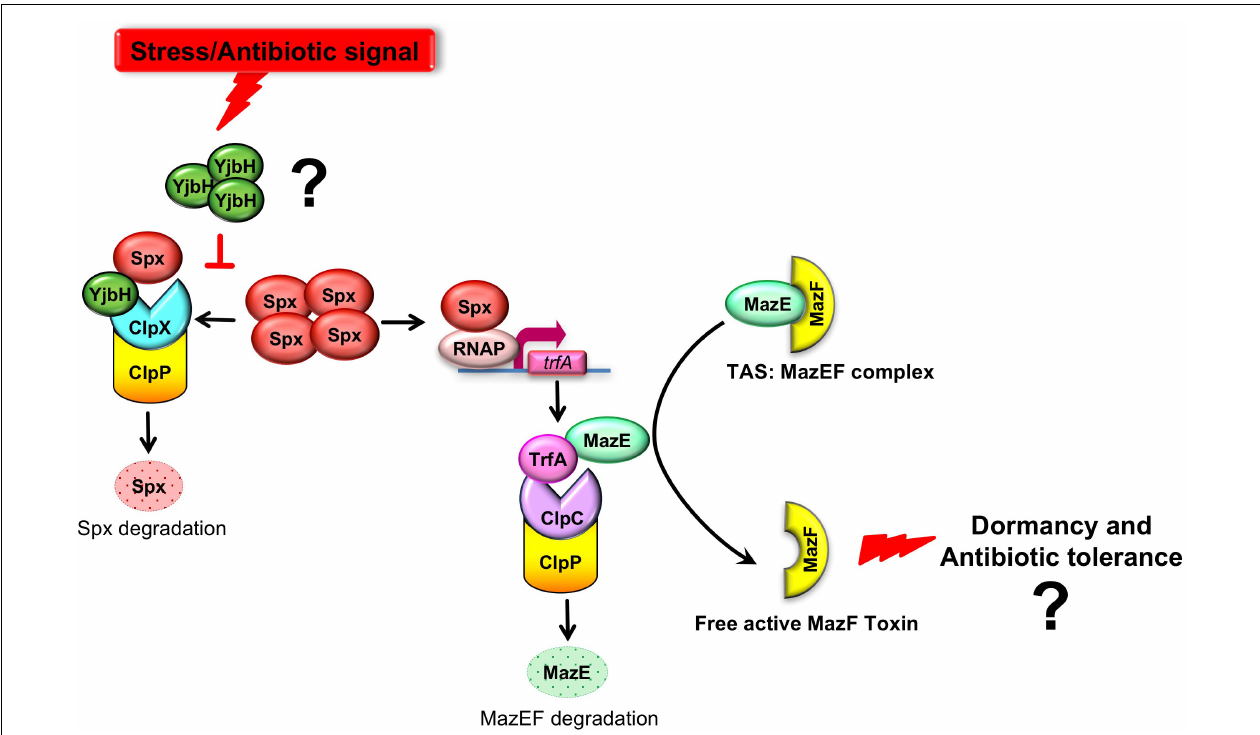
FIGURE 1 | A model where YjbH serves as a sensor of environmental stress and downstream regulation MazEF activity. MazEF complex is composed of MazF toxin and MazE antitoxin which binds MazF and neutralizes MazF activity. MazE is cleaved by the ClpCP degradation module, where ClpC is a chaperone with unfolding activity and ClpP is a protease. MazE degradation is assisted by the adaptor protein TrfA, providing ClpCP specificity and facilitating MazE recognition. The trfA transcription is regulated by the redox sensitive transcriptional factor, Spx. In turn, Spx proteolysis is controlled by ClpXP proteolytic system and requires YjbH adaptor protein. We hypothesized (indicated by question mark) that in S. aureus YjbH aggregates and modulation of YjbH aggregation affects MazEF TAS through the YjbH-Spx-TrfA cascade in response to environmental stresses.